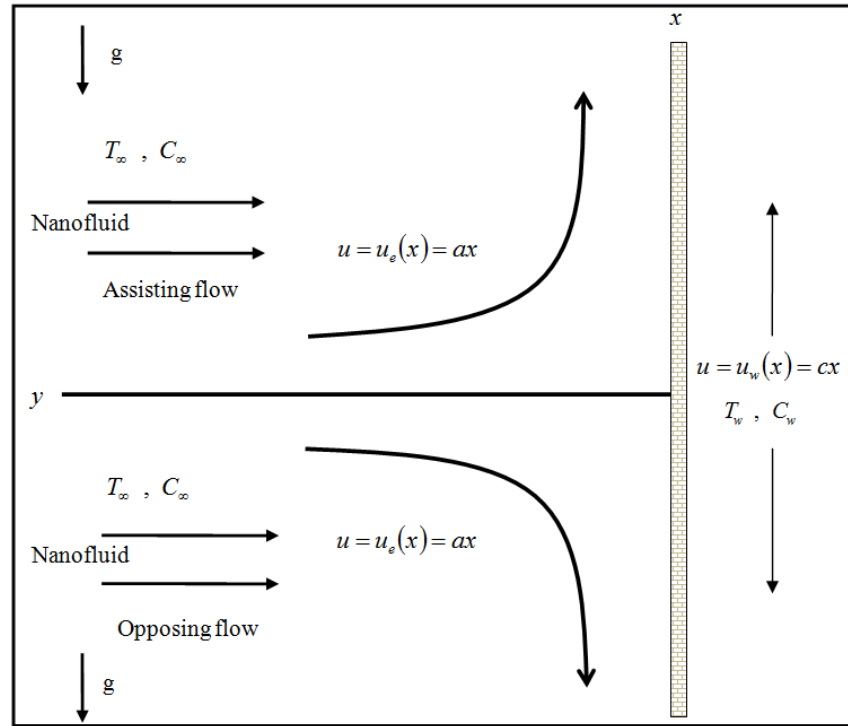
Figure 1. Geometry of the flow in Cartesian